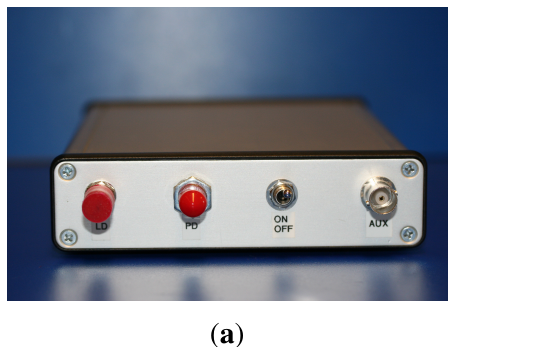
( a ) Front panel view. Ports from left-to-right: laser diode (fiber out), photodetector (fiber